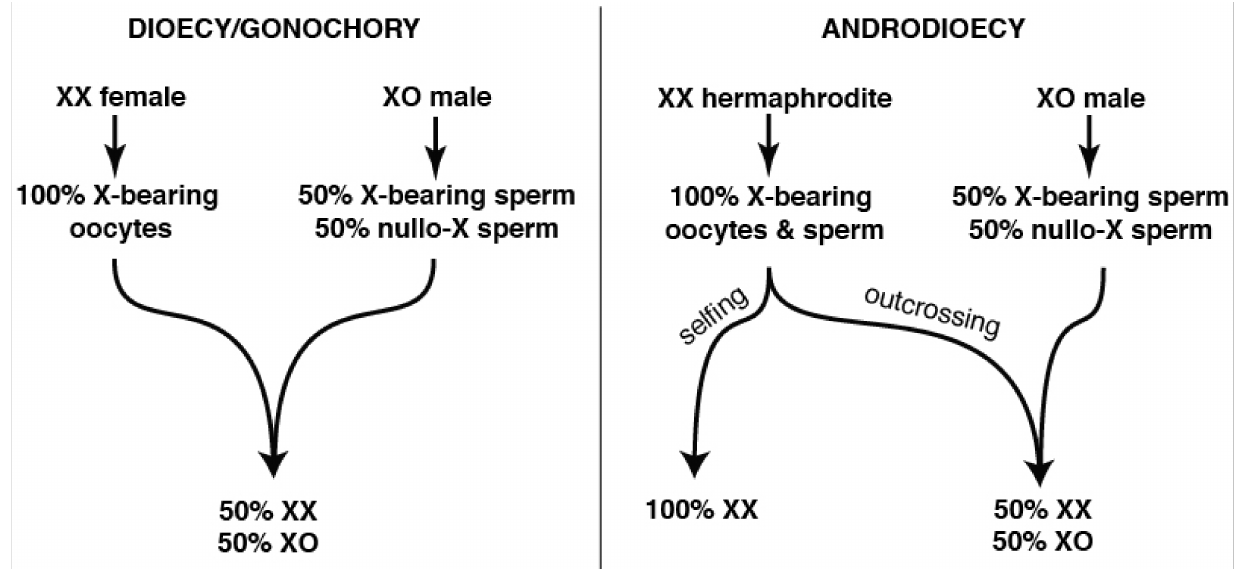
Figure 1. Interaction of XX/XO sex determination and self-fertility. ( Left ): XX/XO sex determination is found in Caenorhab- ditis, Pristionchus , and many other less-studied nematodes. When combined with obligate outcrossing, it reinforces the 1:1 male:female ratio. ( Right ): When XX females evolve self-fertility, purely Mendelian dynamics render the sex ratio dependent upon the extent of selfing vs. outcrossing with XO males. Pure selfing produces almost exclusively XX hermaphrodites, with very rare XO males produced spontaneously through aneuploidy. However, complete suppression of hermaphrodite self-fertility by males recreates the 1:1 ratio of the outcrossing ancestors. Such suppression requires retention of pre- and post-copulatory traits that promote outcrossing, especially in